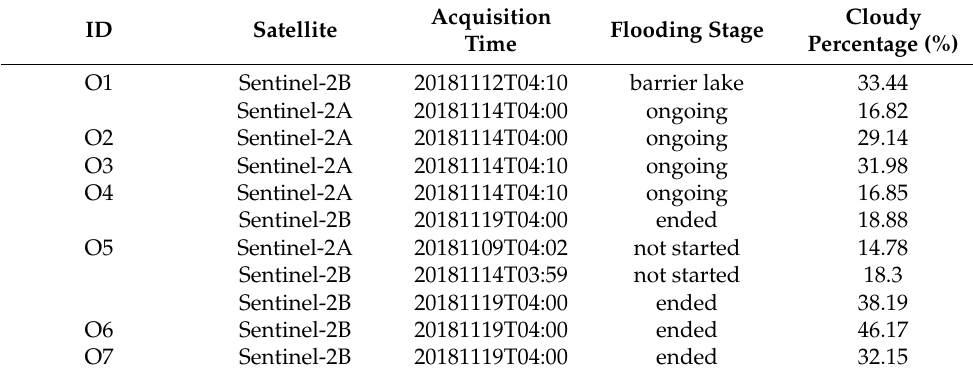
Figure 3. Sentinel-2 images examples used with the different outburst flood scenes. Left: Spatial distribution of three flood mapping scenes. Right: Image examples of corresponding scenes, ( a ) Open flood, landslide barrier lake. ( b ) Open flood, ongoing flood. ( c ) End -of-flood in cloudless area. ( d ) End-of-flood in the cloud-covered area. Table 1. Sentinel-2 optical images characteristics used for this